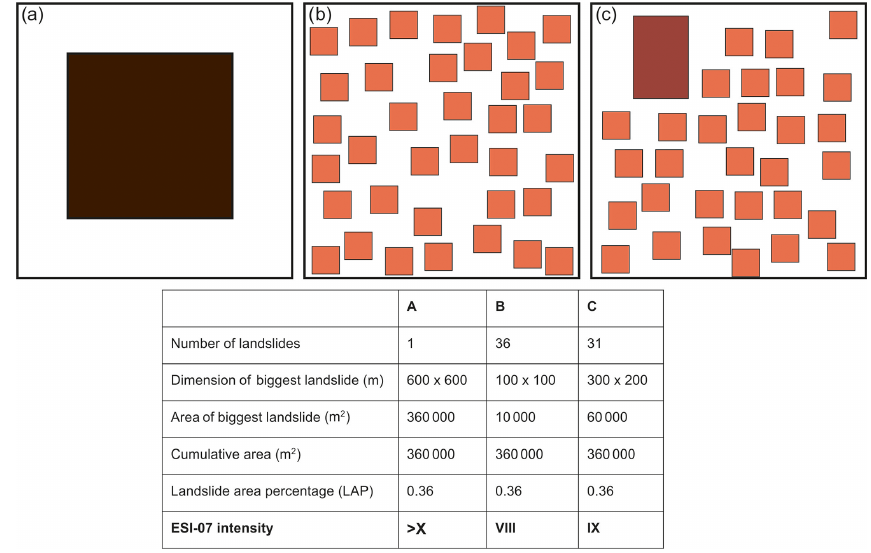
Figure 3. Illustration of the role of number and dimension of landslides (colored squares) on the computation of LND, LAP and ESI-07. The upper panels represent simplified scenarios: (a) one wide landslide; (b) many landslides, all of small dimension; (c) many landslides with variable dimension. Table 1. Area–volume scaling relations considered in this